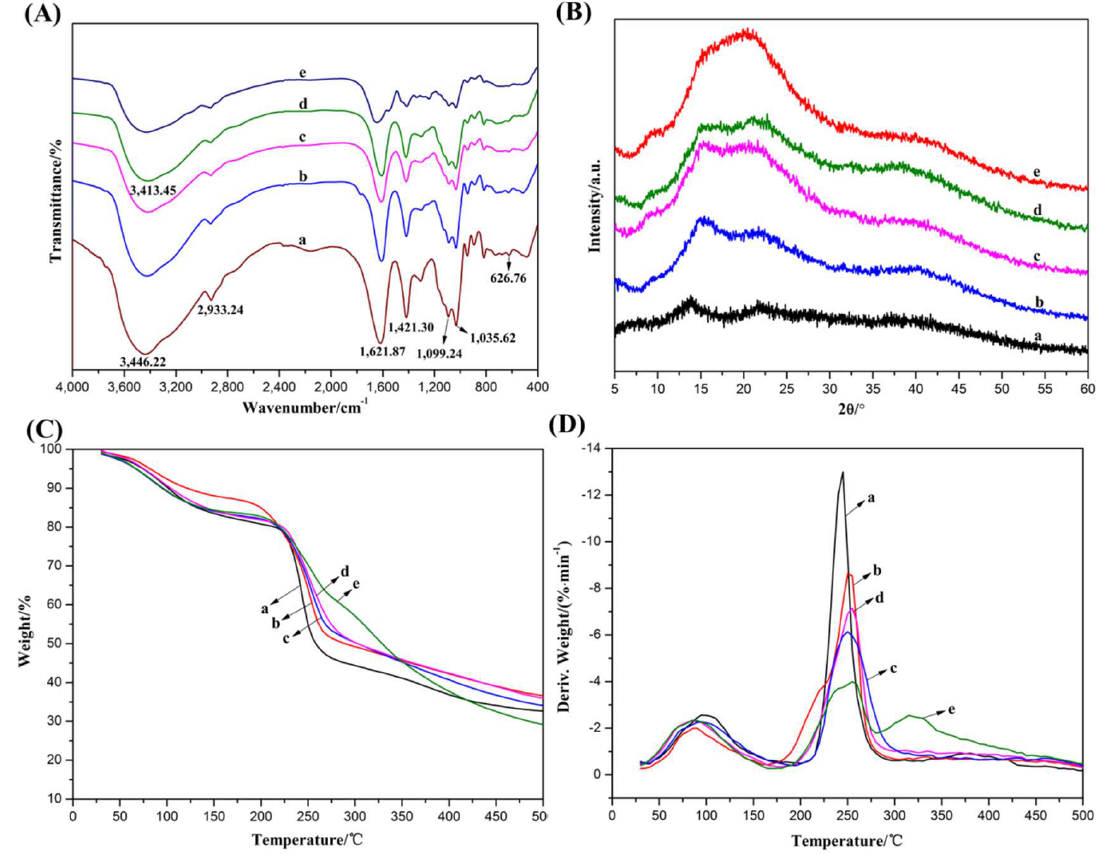
Figure 5. ( A ) FT-IR spectra, ( B ) X-ray diffractions, ( C ) TGA curves and ( D ) DTG curves of the composite hydrogels: (a) SA, (b) Alg Gel, (c) Alg-GT, (d) Alg-CS-GT and (e) Alg/GT-CS.